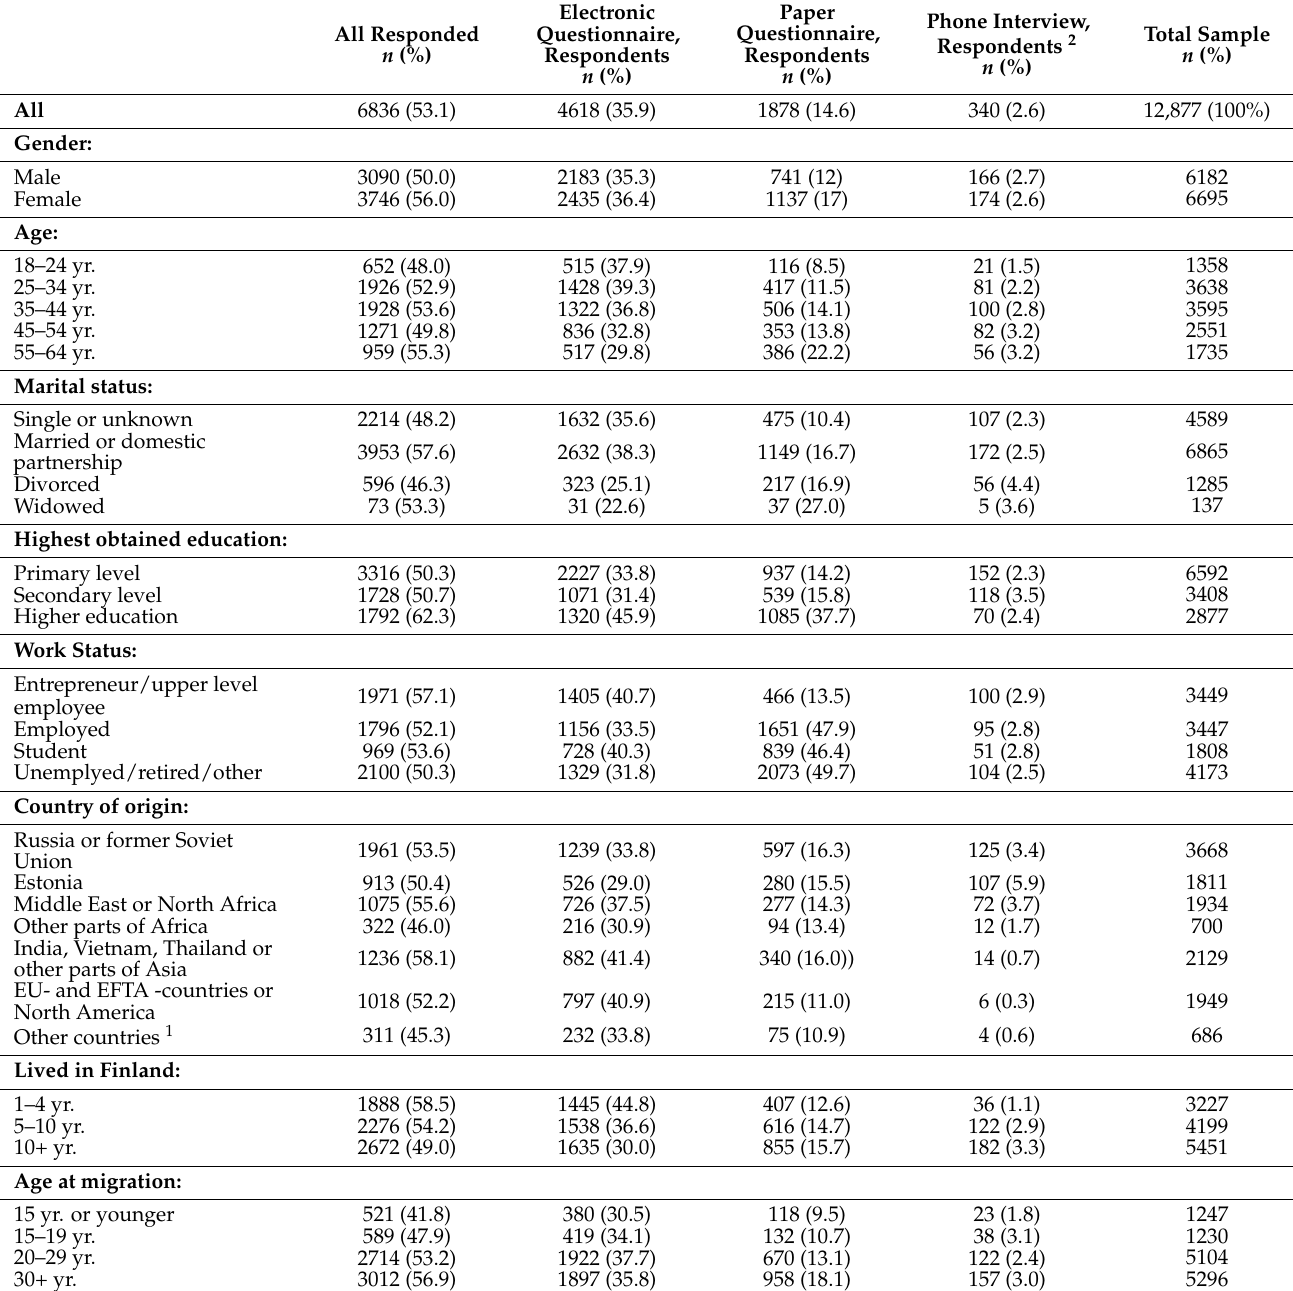
Table 2. Sample size and response rate according to survey format and background